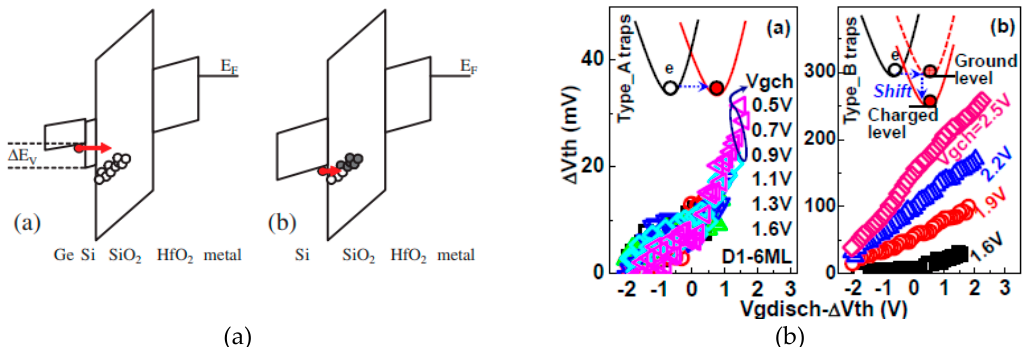
Figure 25. ( a ) Schematic image of the band alignment of the Ge and Si channel gate stacks during NBTI stress. The Ge/Si valence band offset (Si-passivated Ge FETs) causes the inversion layer to energetically move away from the oxide traps [161] and ( b ) defect energy profiles after filling at low and high Vgch vs. Vgdisch- Δ Vth. The insets illustrate the charging mechanisms for two different types of electron traps [162].